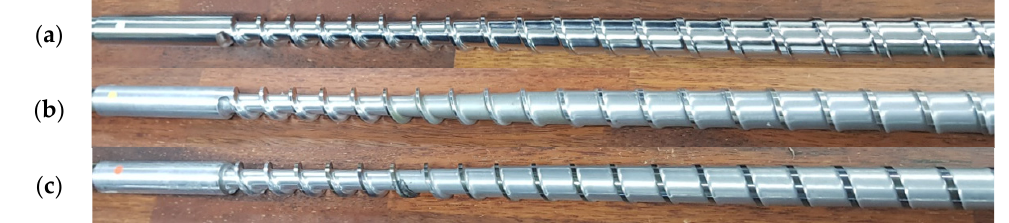
Figure 5. Three screws used in the screw wear experiments: ( a ) wear level 1: intact; ( b ) wear level 2: moderate wear; and ( c ) wear level 3: severe wear.